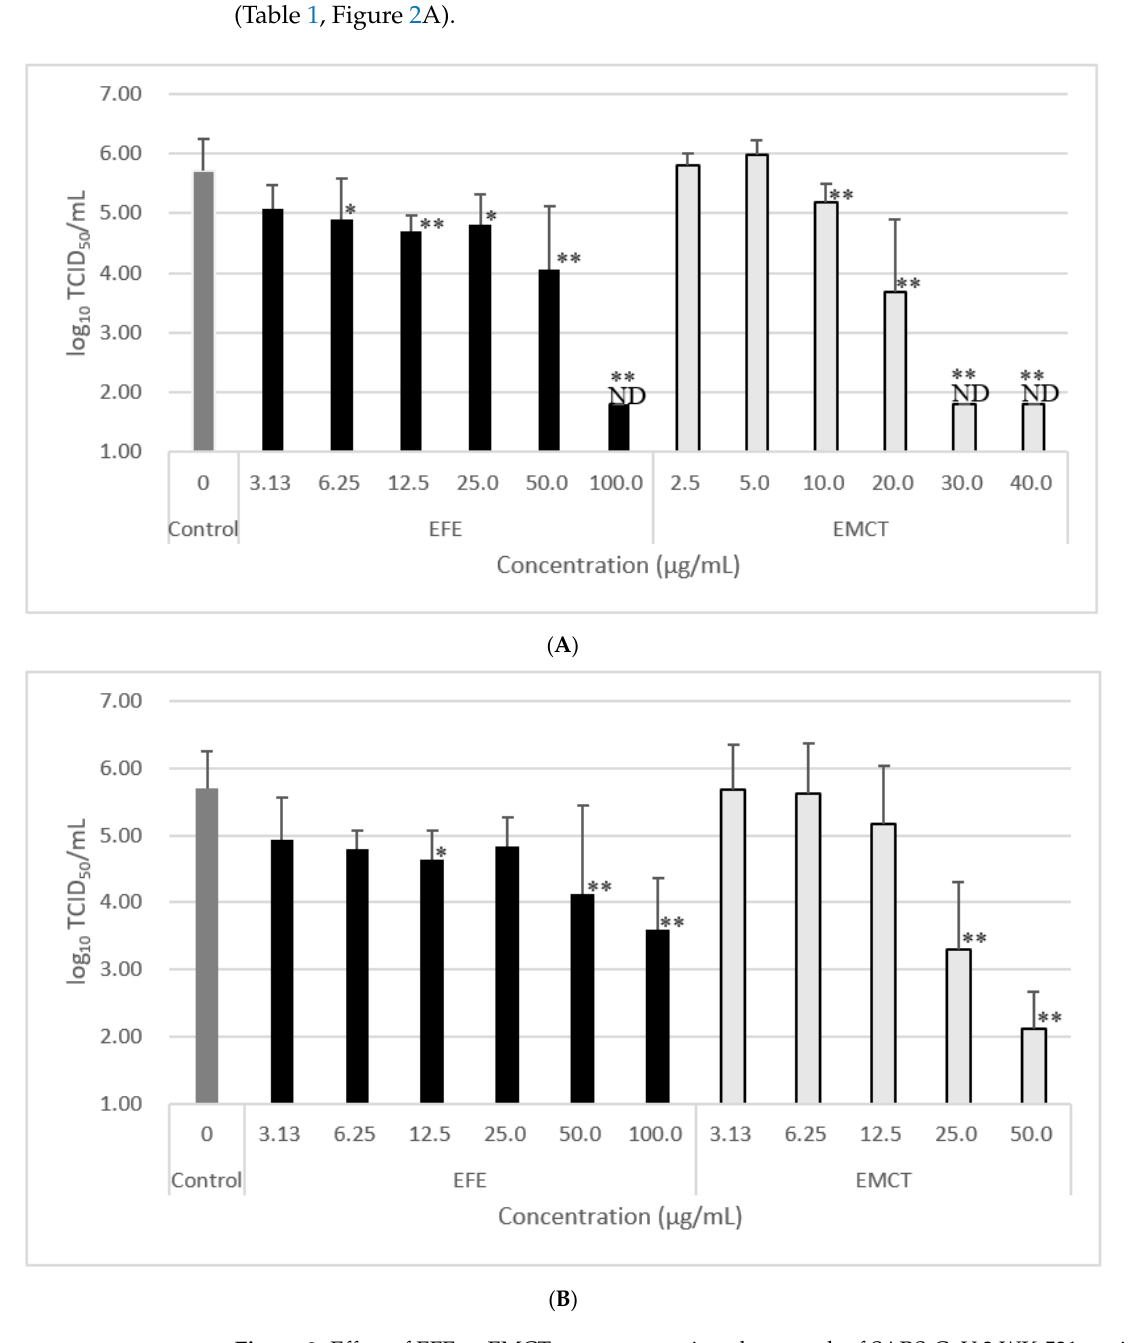
Figure 2. Effect of EFE or EMCT treatment against the growth of SARS-CoV-2 WK-521 strain in vitro at 24 h post-infection. The titer of virus within culture supernatant decreased in a dose-dependent manner. ( A ) EFE or EMCT was added 2 h before virus inoculation. ( B ) EFE or EMCT was added 2 h after virus inoculation. Data are presented as mean ± standard deviation. ND, not detected. Significant differences as compared with control (0 μ g/mL) *; p < 0.05. **; p < 0.01.